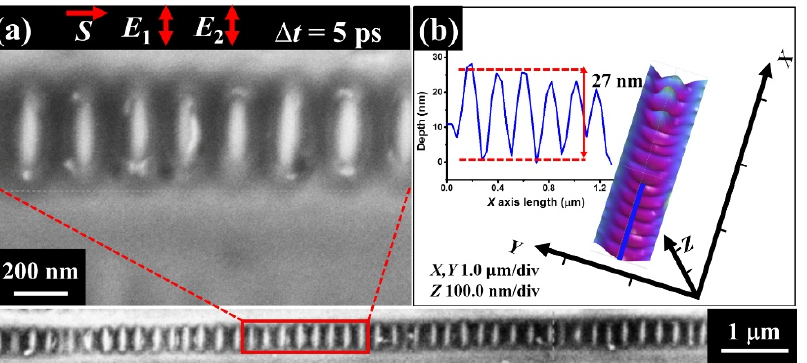
Figure 5. ( a , b ) SEM and AFM images of the laser-induced regular periodic arrays of short-lengthed nanowire structures inside the groove on Fe-based metallic glass. The left inset in ( b ) shows the measured cross-section curve for a small portion (blue line) of the nanostructure arrays in the groove.